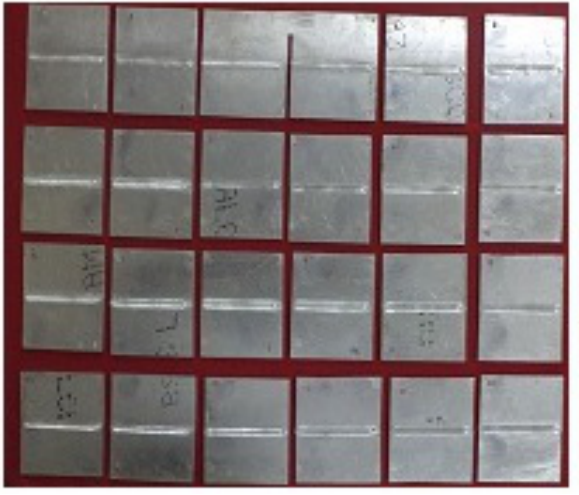
Figure 4: Photograph of fabricated joints ing in rotational speed from 1300 rpm to 1500 rpm, the strength, yield strength and % elongation increased to 376 MPa,285MPaand5.9%respectively.Atconstantrotational speed of 1500 rpm, shoulder diameter of 6 mm and tilt angle of 1.5, an increasing welding speed of 20 mm/min